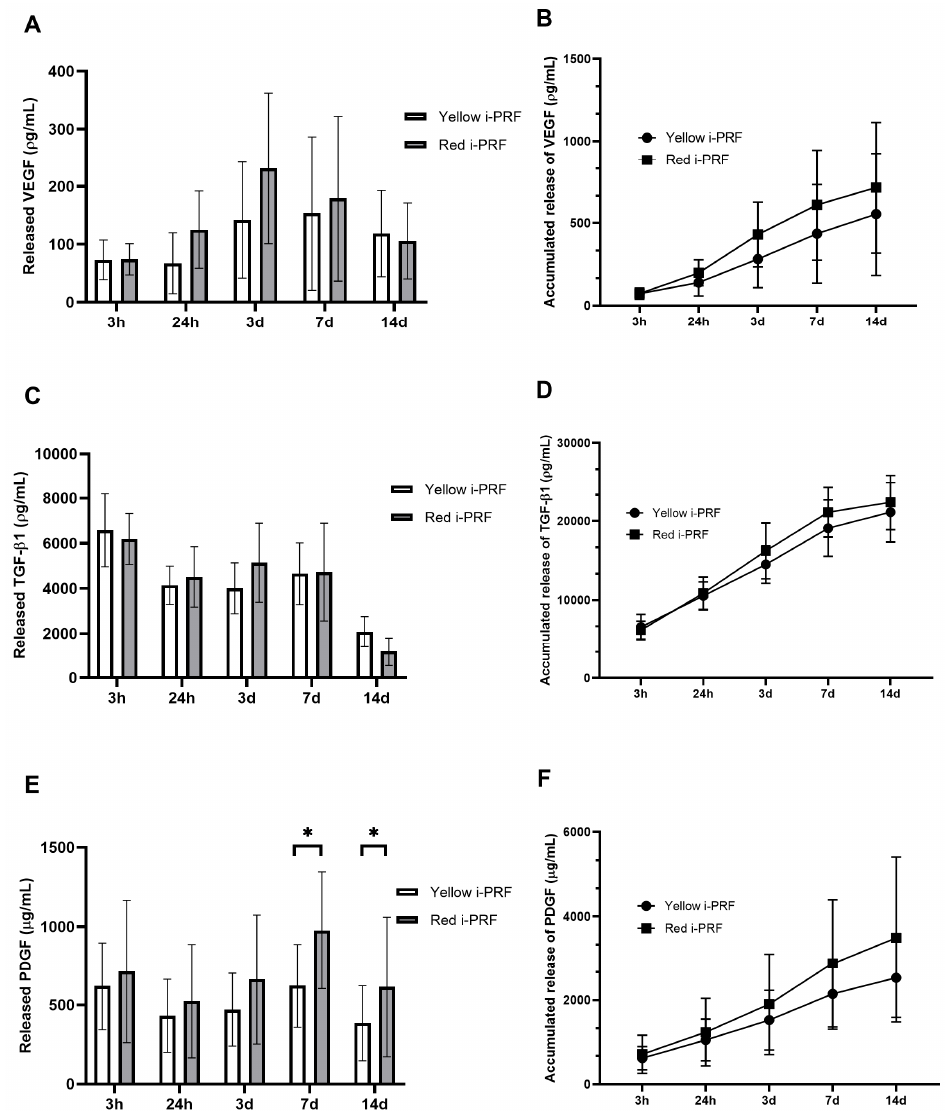
Figure 3. Time point releases and accumulated releases of three growth factors: ( A , B ) vascular endothelial growth factor (VEGF), ( C , D ) transforming growth factor- β 1 (TGF- β 1), and ( E , F ) platelet-derived growth factor (PDGF). * p < 0.05.